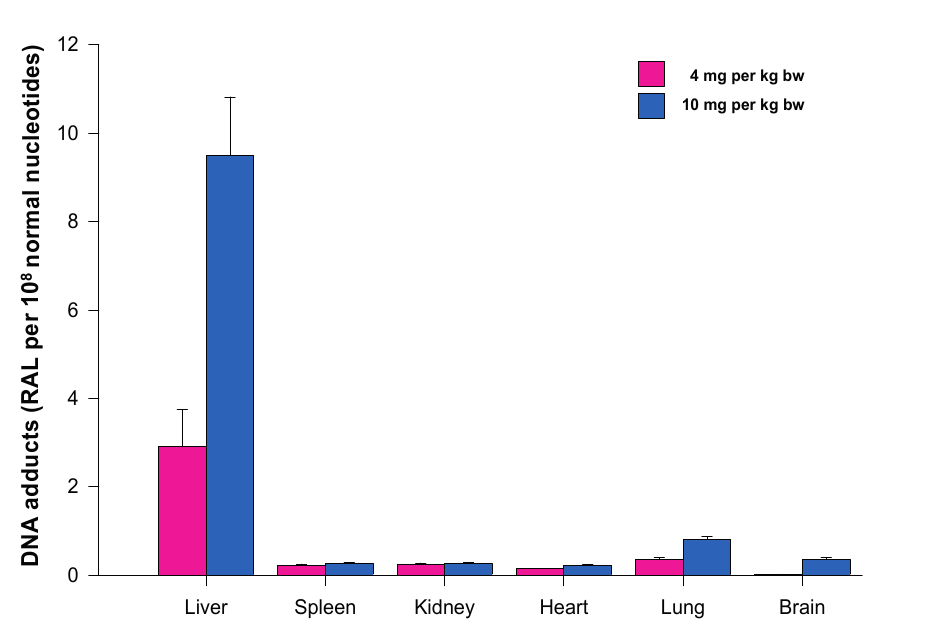
Figure 5. Ellipticine-derived DNA adducts (total levels of DNA adducts) formed in rats treated with ellipticine-micelles (4 and 10 mg ellipticine in micelles per kg body weight (bw)). Data shown are means ± S.D. from three